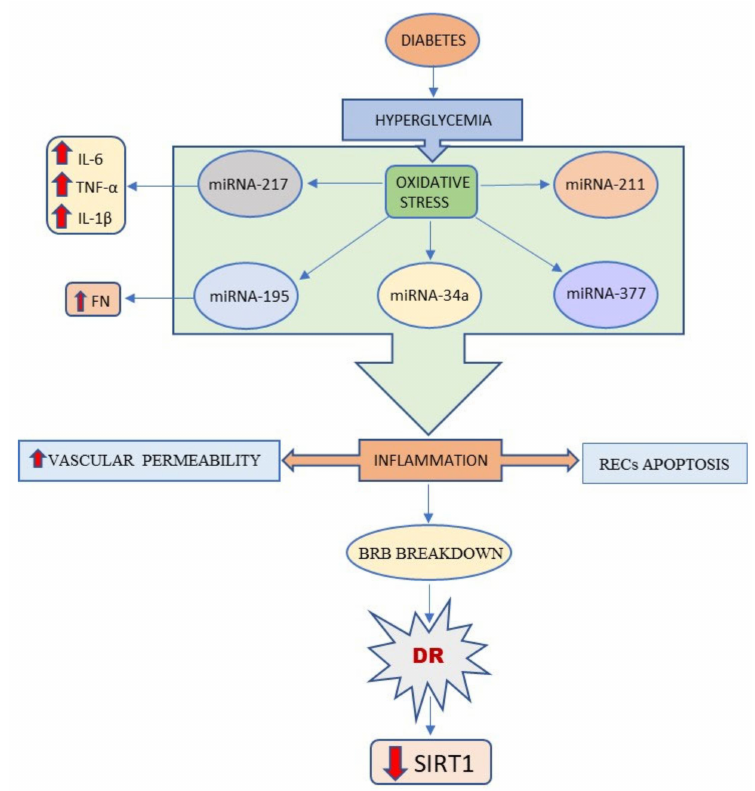
Figure 2. This schema summarizes that Sirt1 expression is reduced in the vascular hyperglycemia. Neovascularization is a fundamental step in DR and PDR development. In HRECs, hyperglycemia increases the expression of the neovascularization markers insulin growth factor1, MMP-2, MMP-9, VEGF, and HIF-1 α [92,93]. Notably, in the presence of high glucose levels, the induced overexpression of SIRT3 in HRECs diminished the expression of factors that facilitate